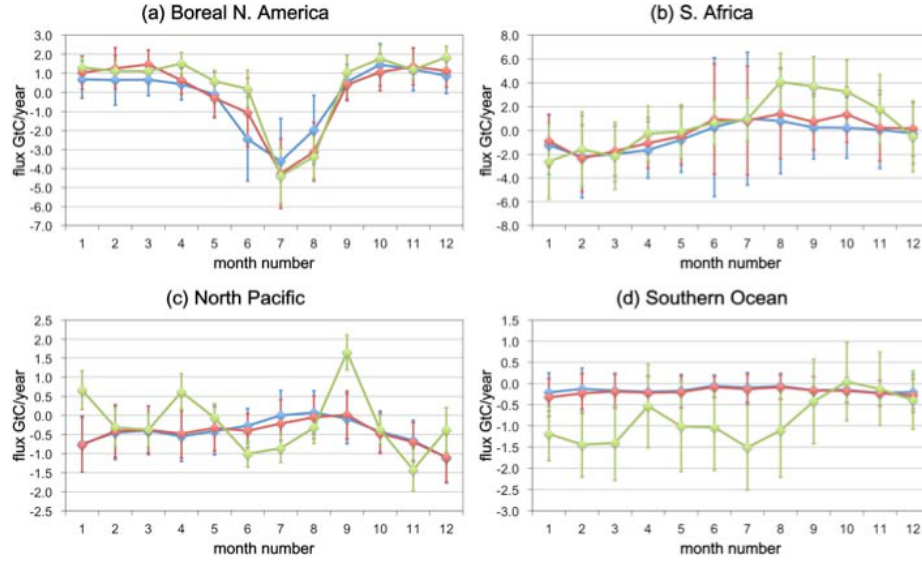
Fig. 6. Mean fluxes for T3 regions with uncertainties. (a) region 1, (b) region 6, (c) region 12, (d) region 20. Blue – prior for EOF, red – estimated with EOF, green – estimated with regions (with NIES TM).